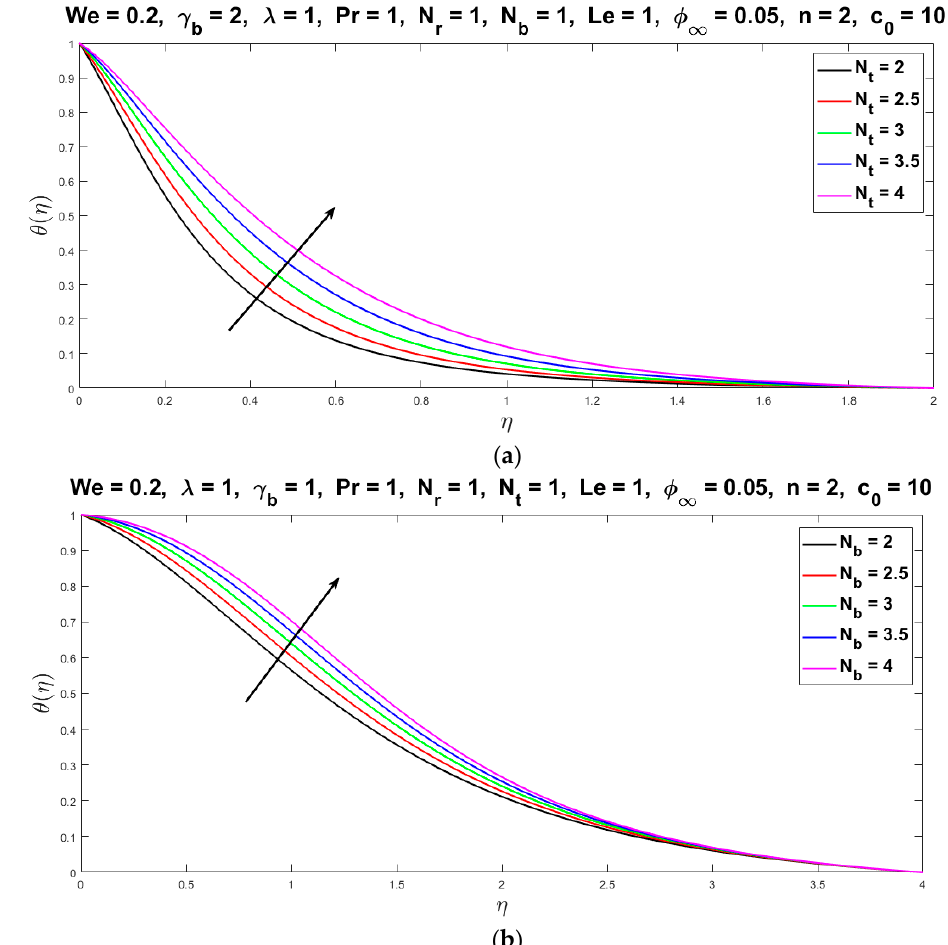
Figure 4. ( a ) Impact of N t over θ . ( b ) Impact of N b over θ .